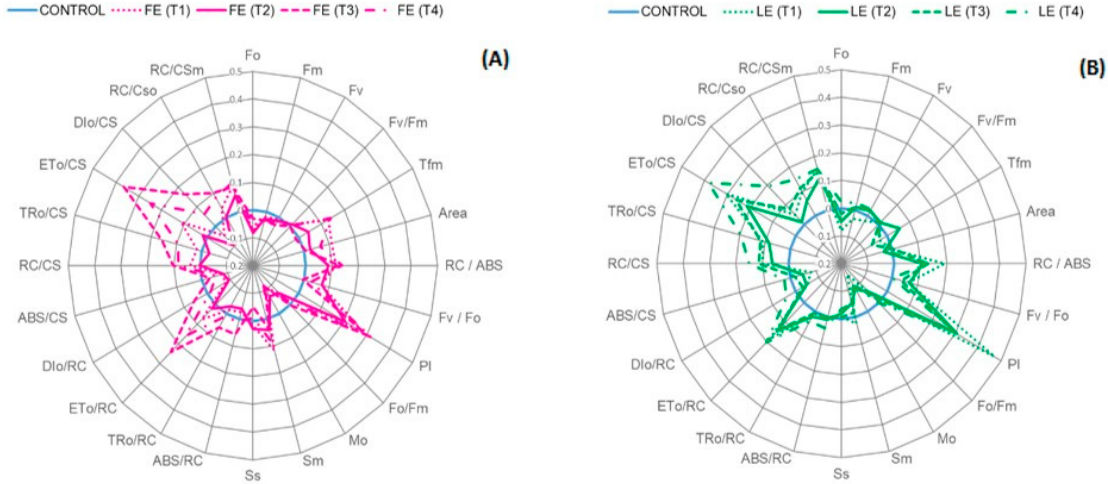
Figure 3. Chlorophyll a fluorescence parameters of rocket leaves treated with water (control) and with borage extracts: ( A ) flowers extract = FE or ( B ) leaves extract = LE, obtained with different maceration times: 1 day (T1), 3 days (T2), 7 days (T3), and 14 days (T4). Values are means ± SE ( n = 4). Data were subjected to one-way ANOVA. Data plotted are fluorescence parameters normalized by formulae: (Ft − Fcw)/Fcw, where “Ft” and “Fcw” represent the parameter values of the treated plants and control plants treated with water, respectively. Values of “Fcw” plants were normalized to 0 (control plants treated with water, blue circle = 0).